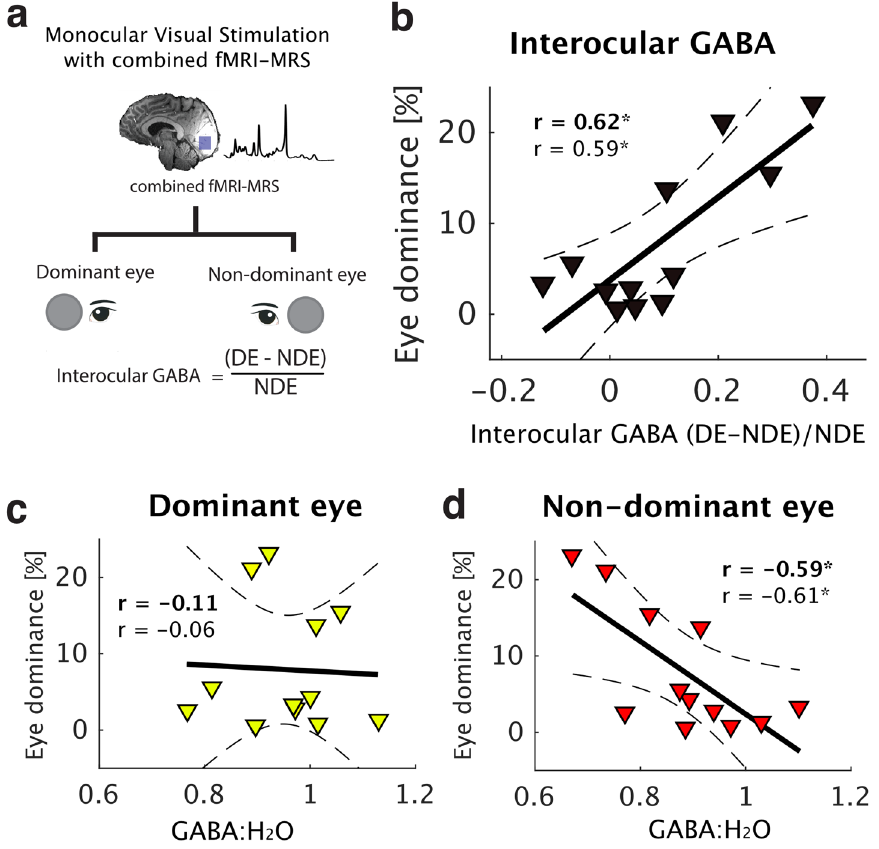
Figure 3. (a) The interocular GABA metric was calculated to show the difference in GABAergic inhibition between activation of the DE or NDE eye. (b) Eye dominance was highly correlated with interocular GABA. Further exploratory analysis showed that (c) eye dominance was not correlated with DE GABA:H 2 O, but that it was correlated with NDE GABA:H 2 O (d) . Solid line represents best fitting linear model, hatched lines represent 95% confidence interval of the regression line. Bold typed r = Spearman’s Rank Correlation Coefficient for GABA scaled to water, ‘ r ’ Spearman’s Rank Correlation Coefficient for GABA scaled to total Creatine, *uncorrected p <